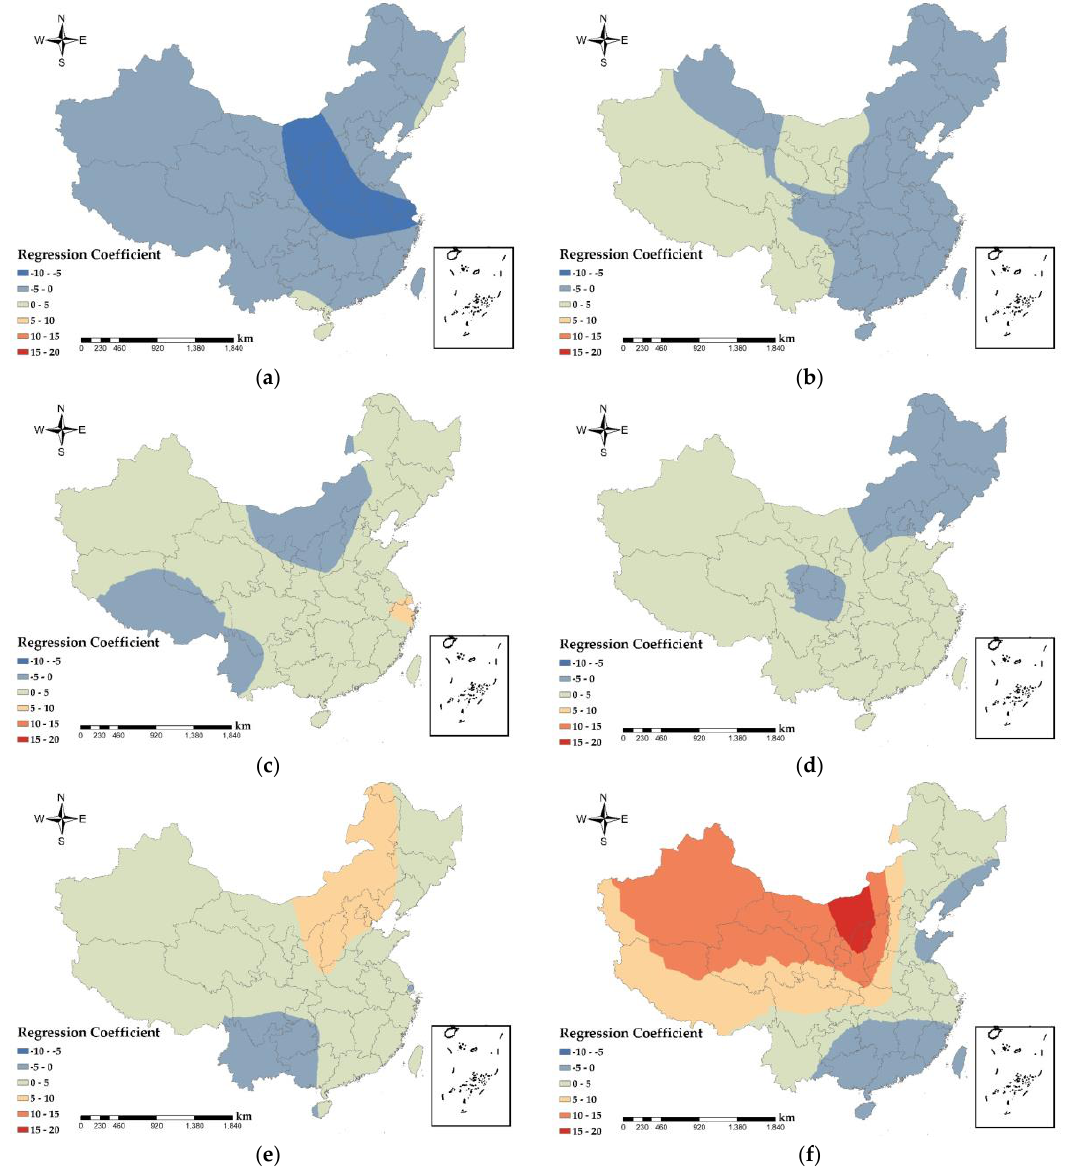
Figure 9. Spatial distribution of regression coefficient (× 10 −3 ) between PM 2.5 concentration and six explanatory variables. ( a ) urban GDP; ( b ) the area of urban green space; ( c ) road area; ( d ) number of taxis; ( e ) number of buses; and ( f ) number of factories.